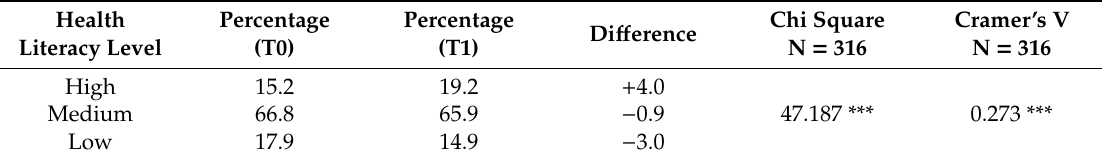
Table 7. Proportion of children (11 years and older) with di ff erent levels health literacy.